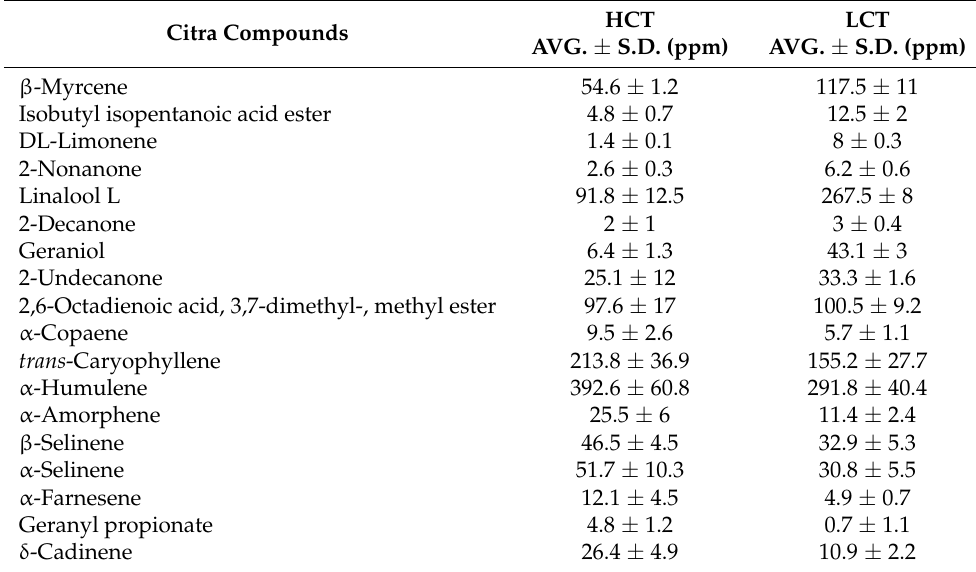
Table 7. Citra compound distribution in HCH and LCH samples showing triplicate average (AVG.) and standard deviation